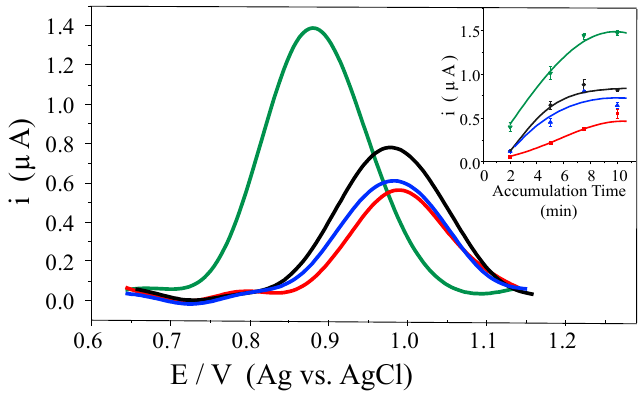
Figure 6. Differential pulse voltammograms obtained in 0.1 M PBS (pH 7.0) using a GCE modified with CRGO (red); hTRGO (black); ERGO (blue); and TRGO (green) (1.0 mg/mL) after 10 min accumulation of the Oligo solution. Inset: Dependence of the guanine oxidation current with the accumulation time from a 15 µM Oligo solution at an open circuit potential.